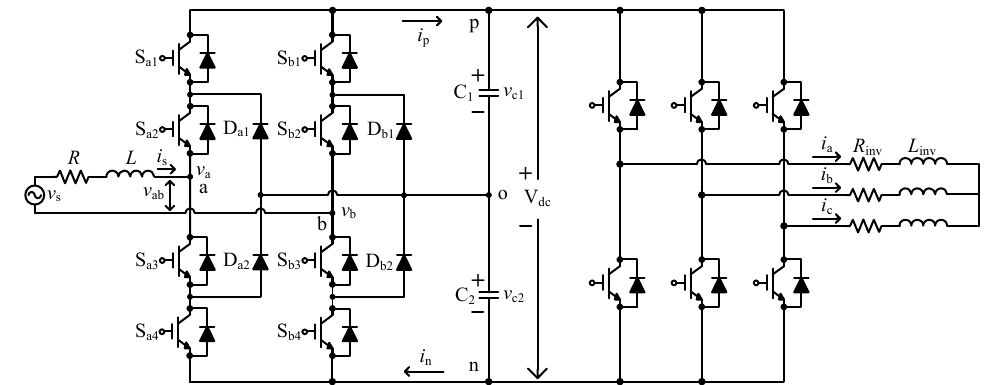
Figure 17. Schematic with a three-phase voltage source inverter as a nonlinear load.